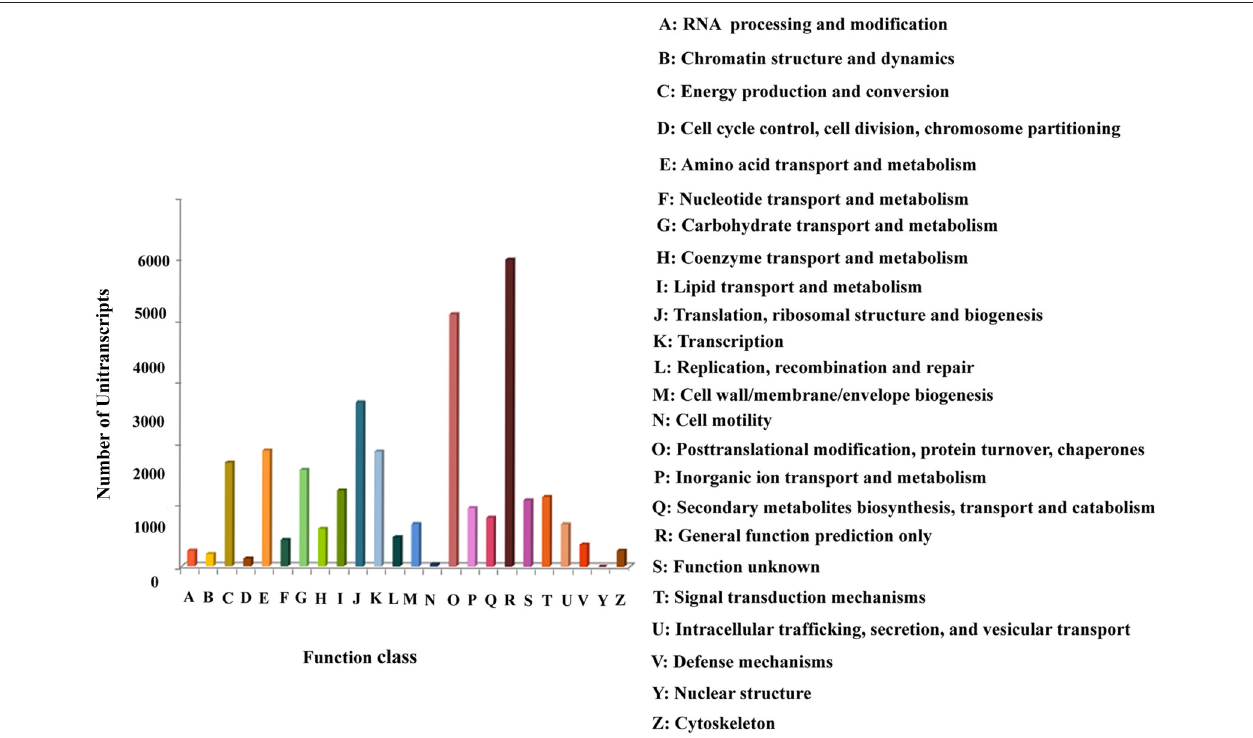
FIGURE 4 | Clusters of Orthologous Groups (COG) classification of P. amarus unitranscripts.